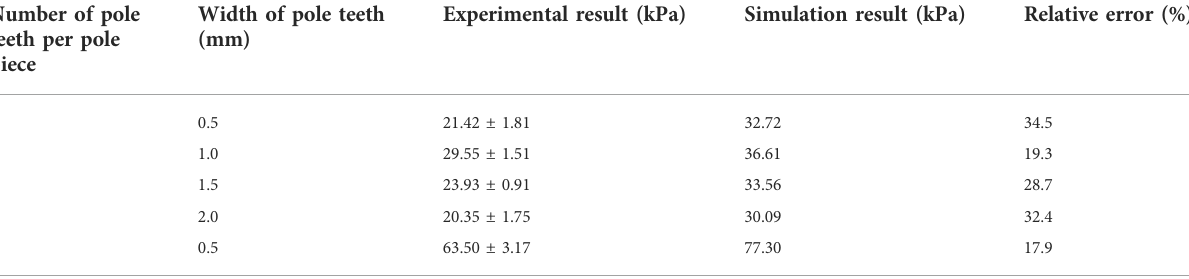
TABLE 1 Comparison between simulation and experimental results of different FF sealing structures. Number of pole teeth per pole piece